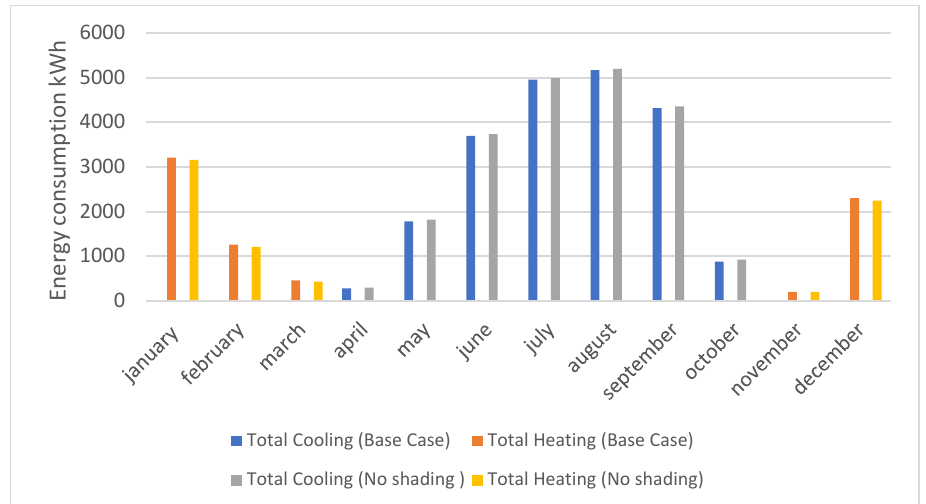
Figure 20. Annual energy consumption for Case 2 with and without shading device.